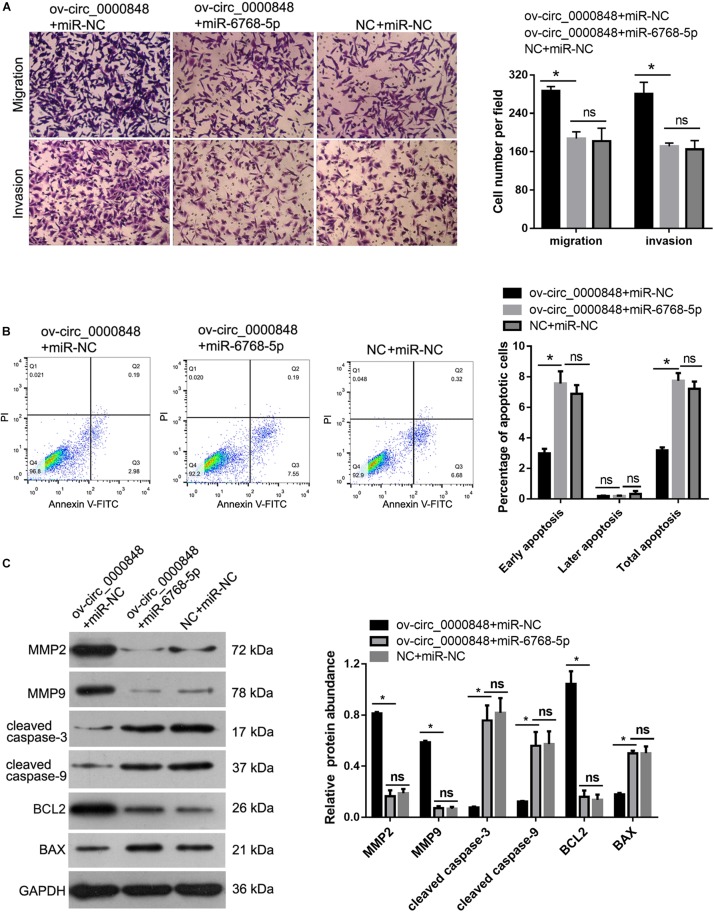
hsa-miR-6768-5p overexpression eliminated the effect of hsa_circ_0000848 overexpression in HTR-8 cells. To confirm whether hsa_circ_0000848 acts by sponging hsa-miR-6768-5p, hsa_circ_0000848 overexpressing plasmid and hsa-miR-6768-5p mimics were co-transfected into HTR-8 cells to carry out rescue assays. Cells transfected with NC plus miR-NC or ov-circ_0000848 + miR-NC were used as controls. The results showed that hsa-miR-6768-5p overexpression eliminated the effect of hsa_circ_0000848 overexpression on migration, invasion (A), apoptosis (B) and protein abundance of MMP-2, MMP-9, cleaved caspase-3, cleaved caspase-9, BCL2 and BAX (C) in HTR-8 cells. *P < 0.05 using unpaired t-tests.